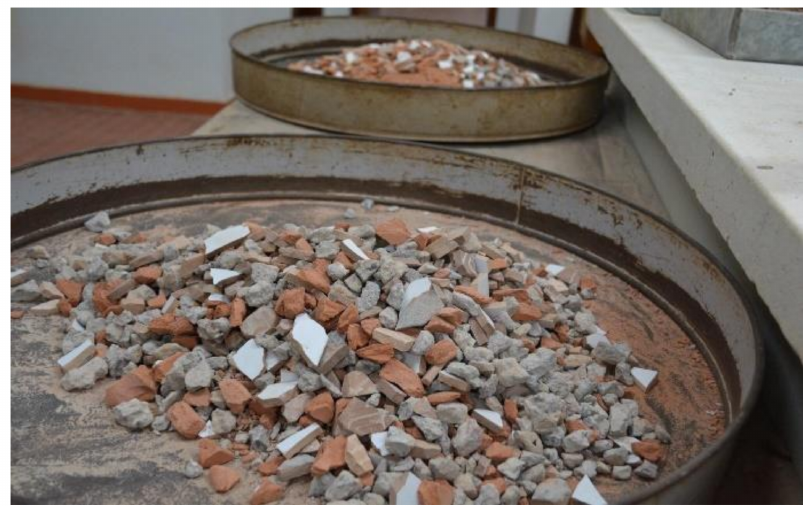
Figure 2. Aspects of a sample of CDW from a construction site after separation by type and particle